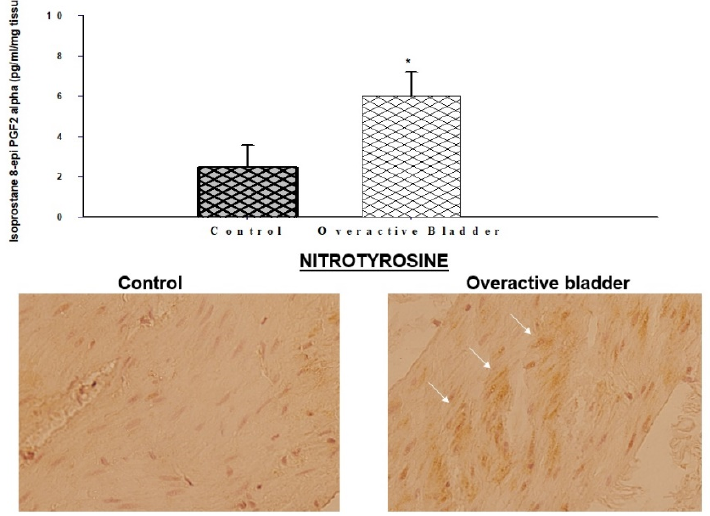
Figure 1. Markers of oxidative and nitrosative stress in bladder ischemia. Expression levels of the oxidative stress product isoprostane 8-epi PGF2 α are upregulated in the ischemic overactive bladder as shown in the upper panel. In the lower panel, immunostaining shows diffuse nitrotyrosine immunoreactivity in the ischemic overactive bladder, suggesting nitrosative stress. * Indicates significant difference versus control. Arrows point to nitrotyrosine immunopositive areas. This figure is taken from our previous publication [40].